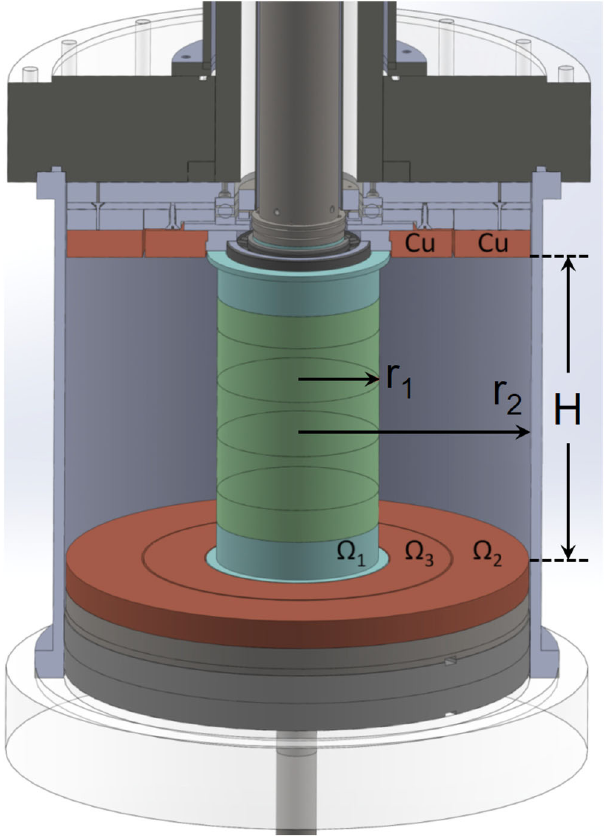
Fig. 6 | Sketch of the Taylor – Couette cell used in the experiment. The cell has three independently rotatable components: the inner cylinder ( Ω 1 ), outer-ring- bound outer cylinder ( Ω 2 ), and upper/lower inner rings ( Ω 3 ). This plot was created by the authors and previously published 34 .